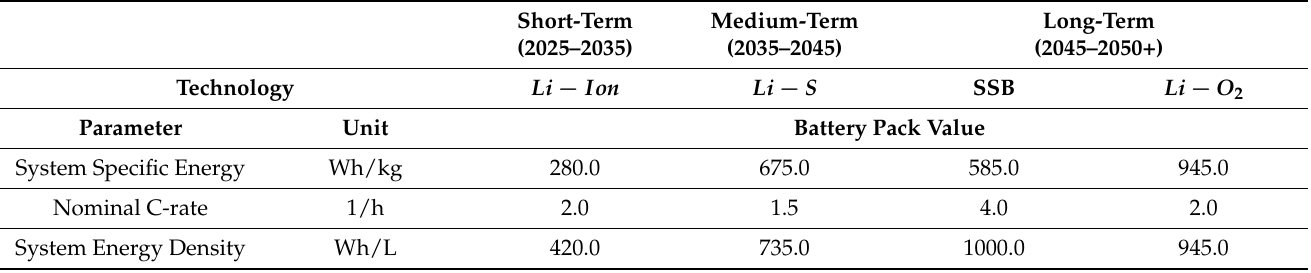
Table 5. Gravimetric and volumetric characteristics of different types of batteries.